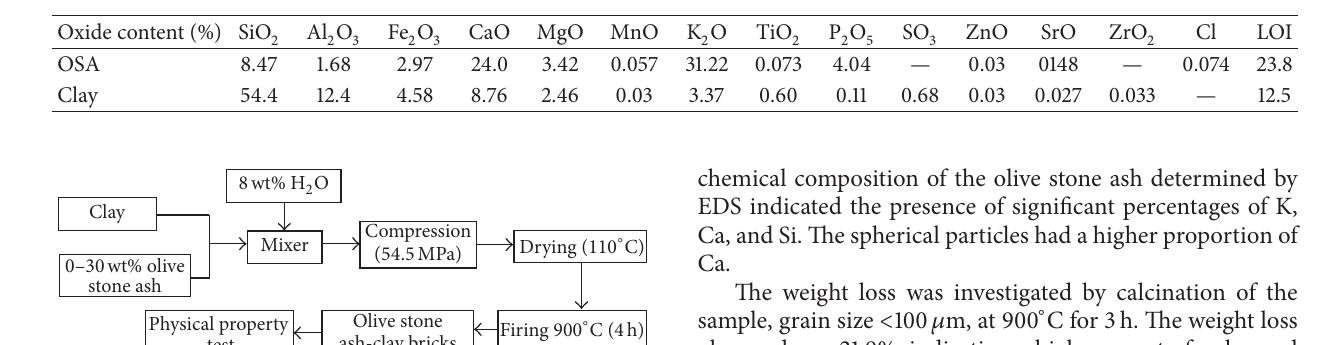
Table 2: Chemical composition of OSA and clay.